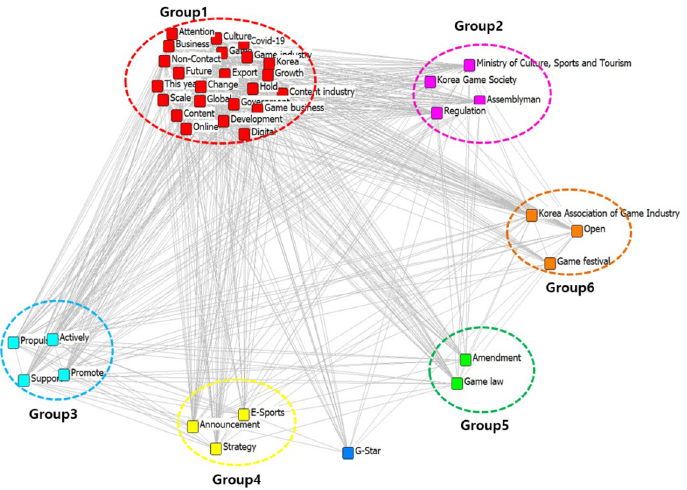
Fig 9. Visualization of CONCOR analysis of 40 important keywords in